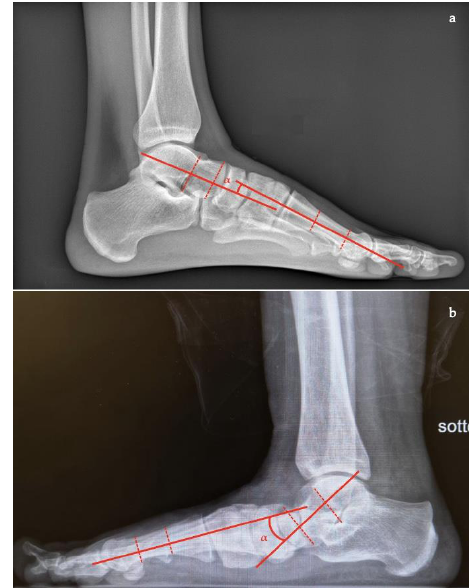
Figure 4. Talar incongruency angle (formed by the intersection between a line from the most lateral point of the articular surfaces of the talus and the navicular, and a line from the lateral aspect of the talar neck (in its most narrow segment) to the lateral point of the talar articular surface). ( a ) Normal foot, 6°; ( b ) pathological flatfoot, >30°.